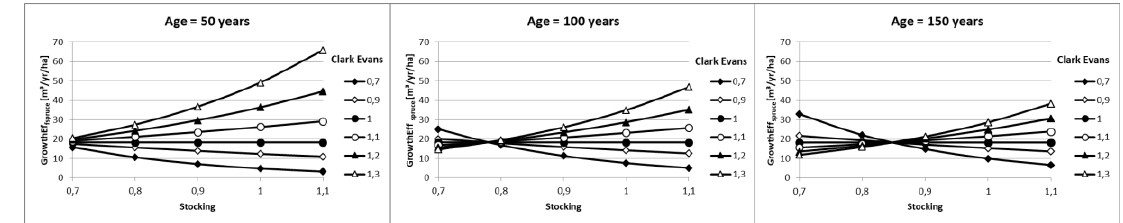
Figure 9. Growth efficiency of spruce depending on its spatial distribution, age, and stocking.